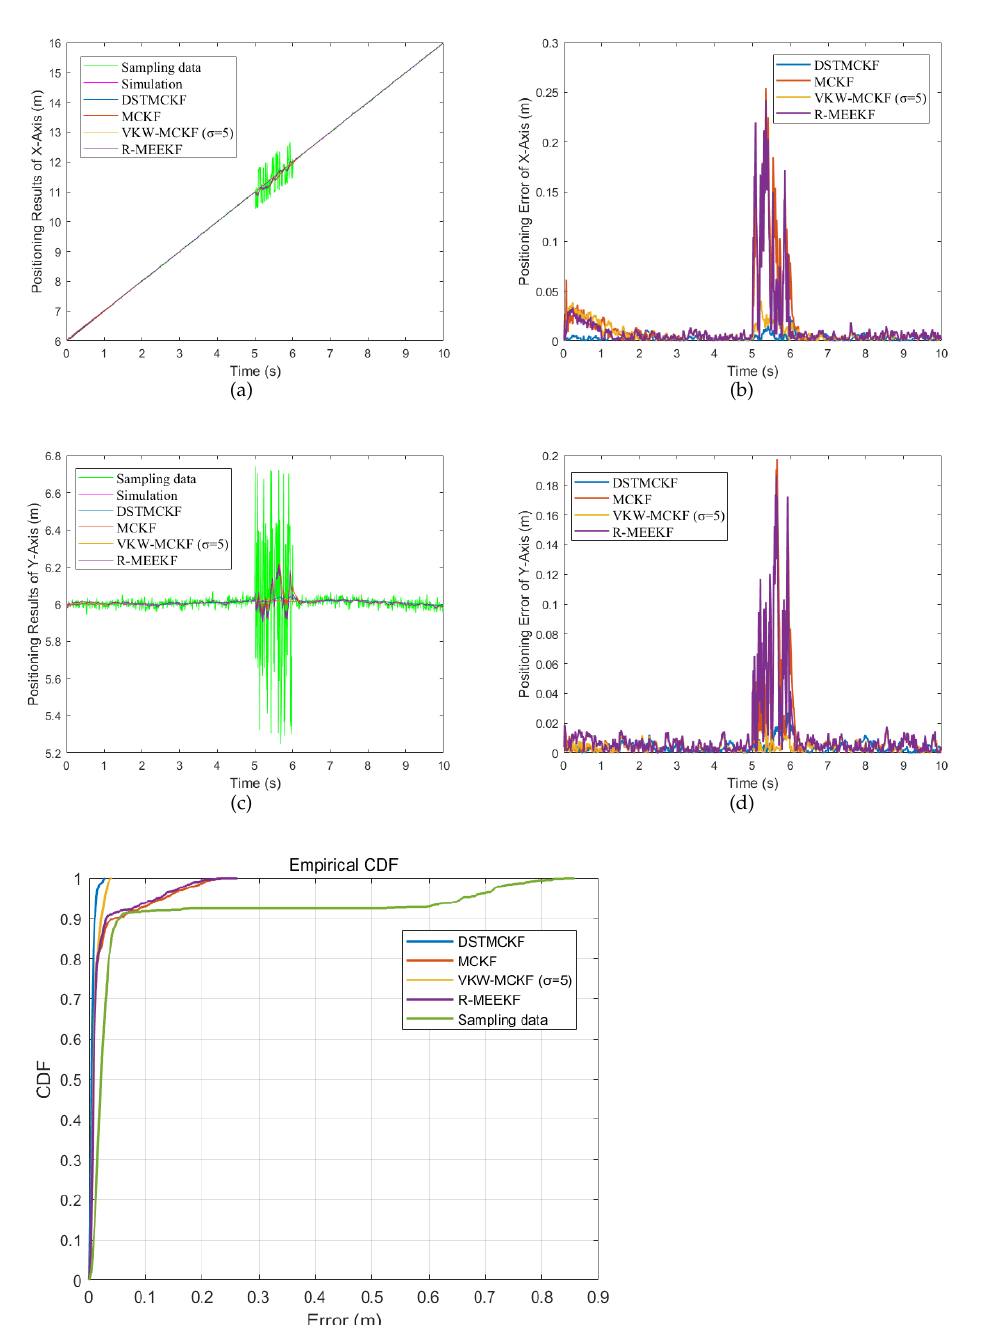
Figure 7. Simulation Results in Case (2). ( a ) Positioning result of X-label when σ = 1.2; ( b ) error of X-label when σ = 1.2; ( c ) positioning result of Y-label when σ = 1.2; ( d ) error of Y-label when σ = 1.2; ( e ) CDF of each filter when σ =